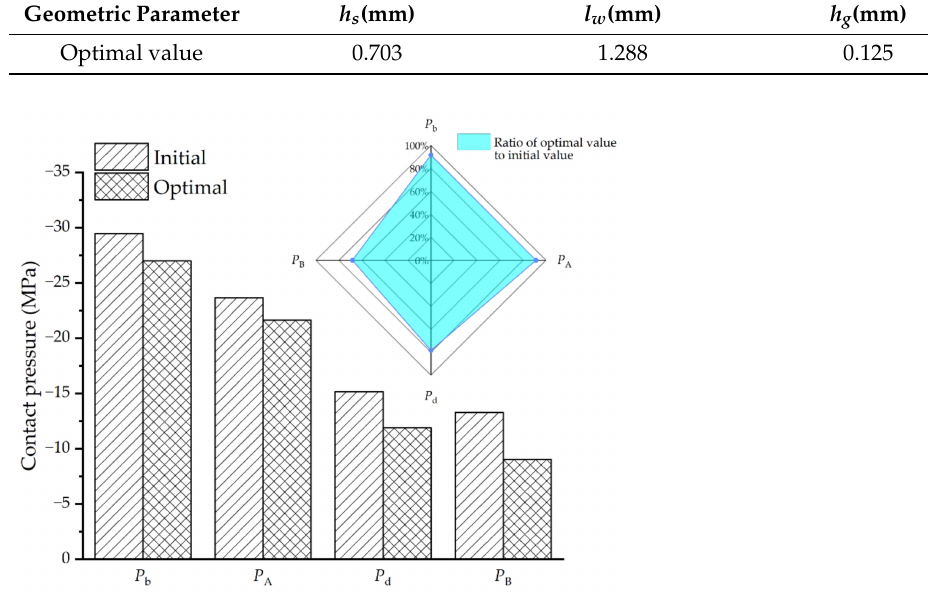
Figure 18. Optimization results and